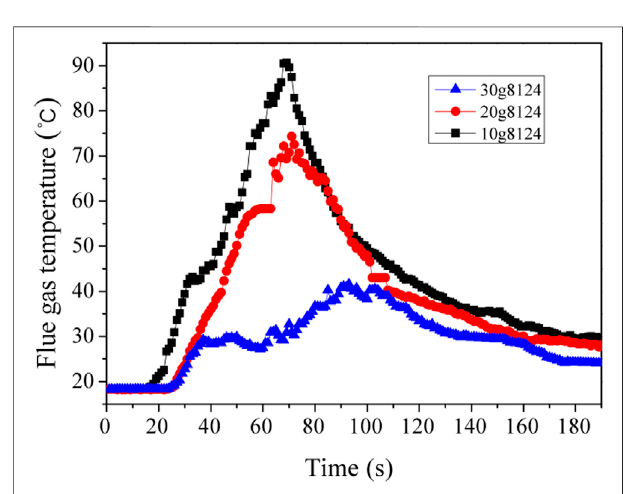
FIGURE 8 | The result of fl ue gas temperature by using foam with